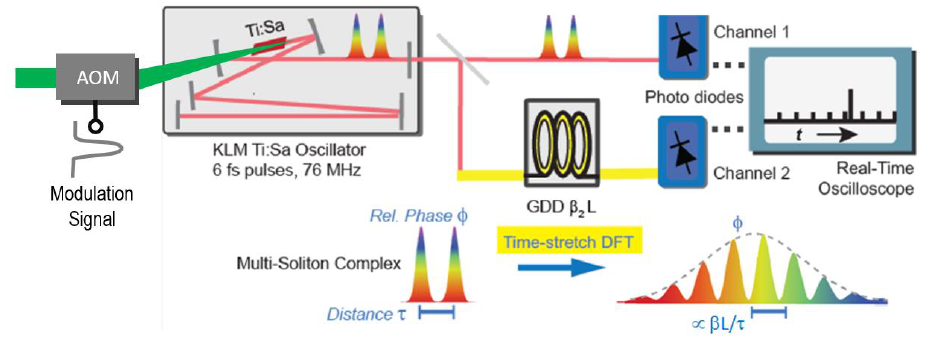
Fig. 1 Real-time detection of transient soliton molecules via TS-DFT and spectral interferometry: Soliton separations and relative phases are recorded via time-stretch spectral interferometry. Active control of soliton dynamics is achieved via rapid modulations of the pump power facilitated by acousto-optic beam